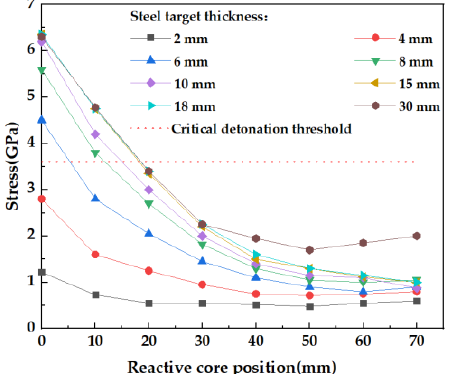
Figure 4. Peak stresses of the projectiles penetrating steel target.